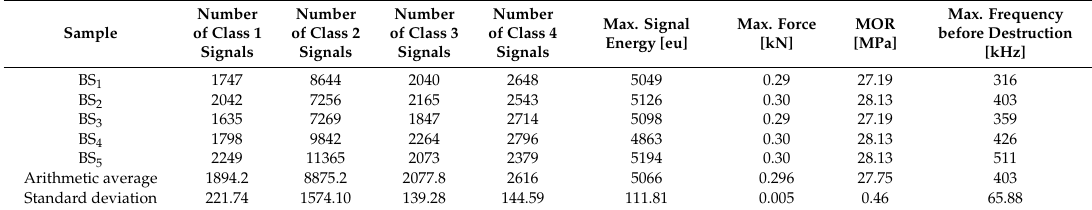
Table 4. Summary of research results for BS samples.